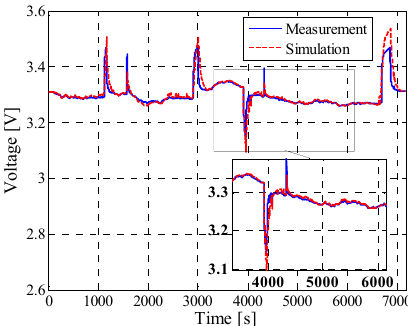
Figure 26. Measured and estimated voltage profiles obtained for the field-measured current profile at T = 25 °C.